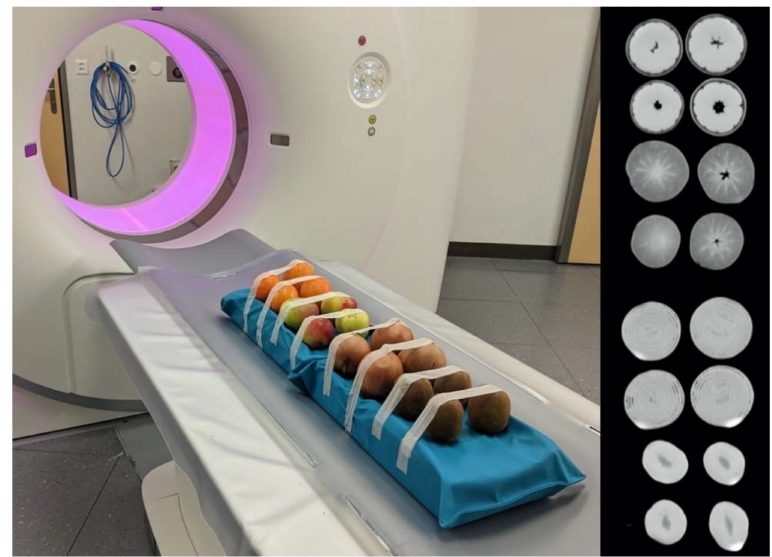
Figure 1. Phantom setup. Photograph ( left ) and axial CT image ( right ) of the phantom consisting of four kiwifruits, four onions, four apples, and four oranges simulating different CT attenuation and tissue